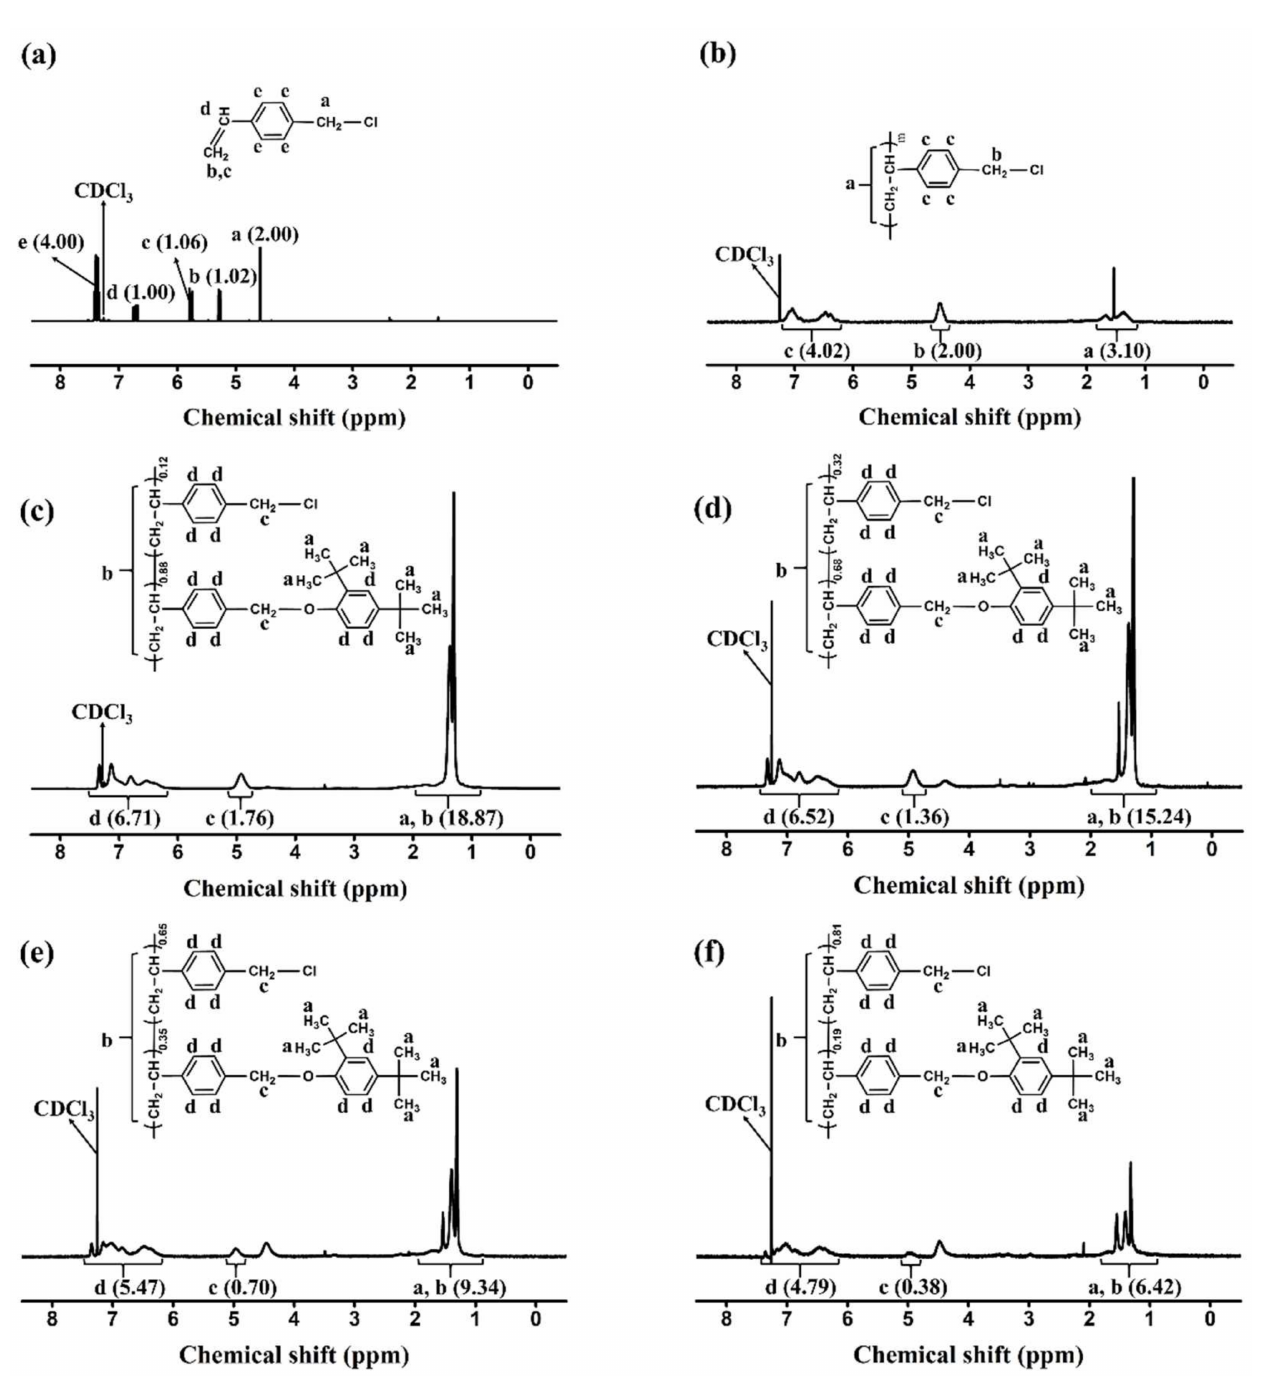
Figure 2. 1 H nuclear magnetic resonance ( 1 H NMR) spectra of: ( a ) CMS, ( b ) PCMS, ( c ) PD t BP88, ( d ) PD t BP68, ( e ) PD t BP35, and ( f ) PD t